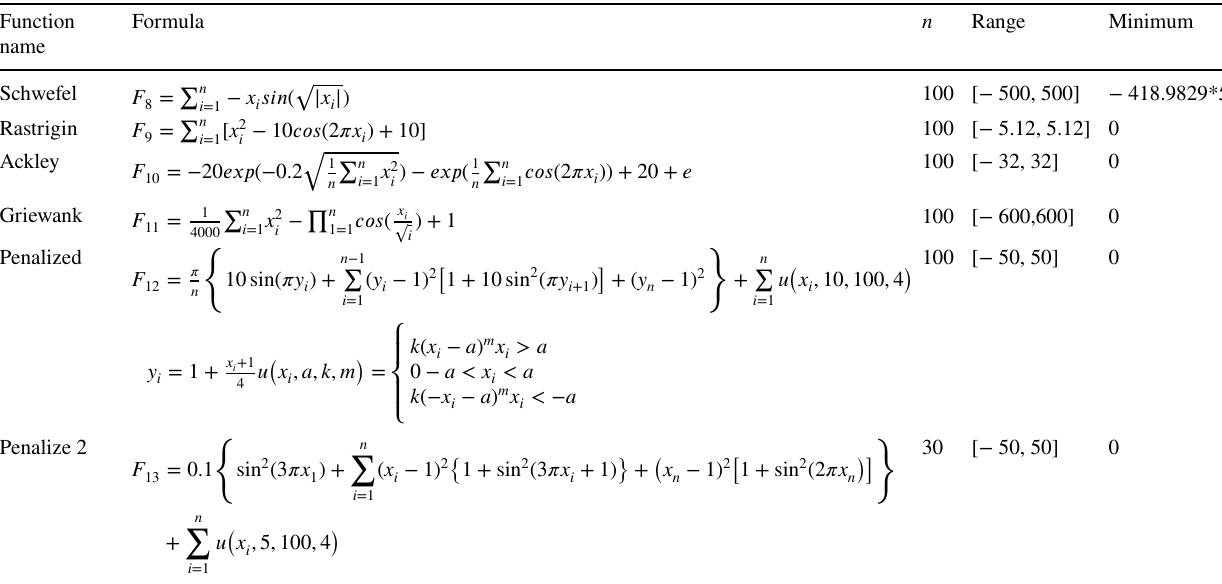
Table 2 Multimodal benchmark functions Function name